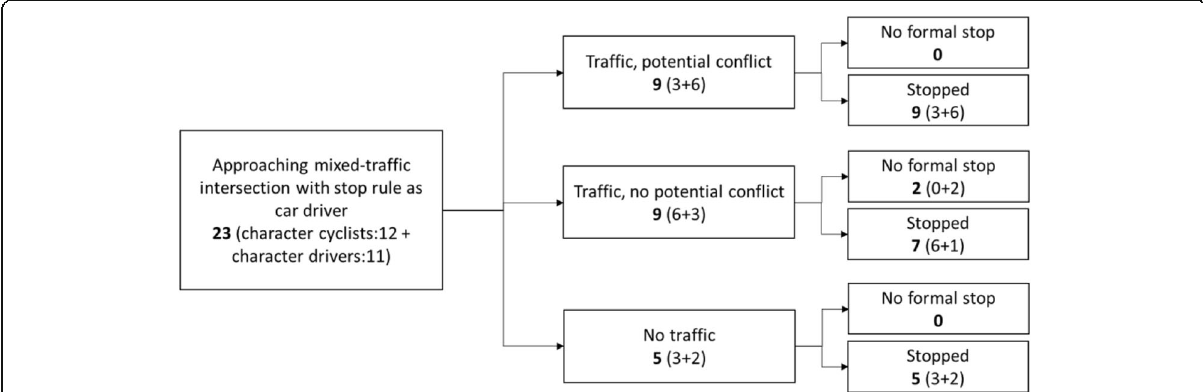
Fig. 4 Stopping behaviour when driving in mixed traffic at the intersection with stop rule. Results in total (number of outcomes for character cyclists + number of outcomes for character drivers)